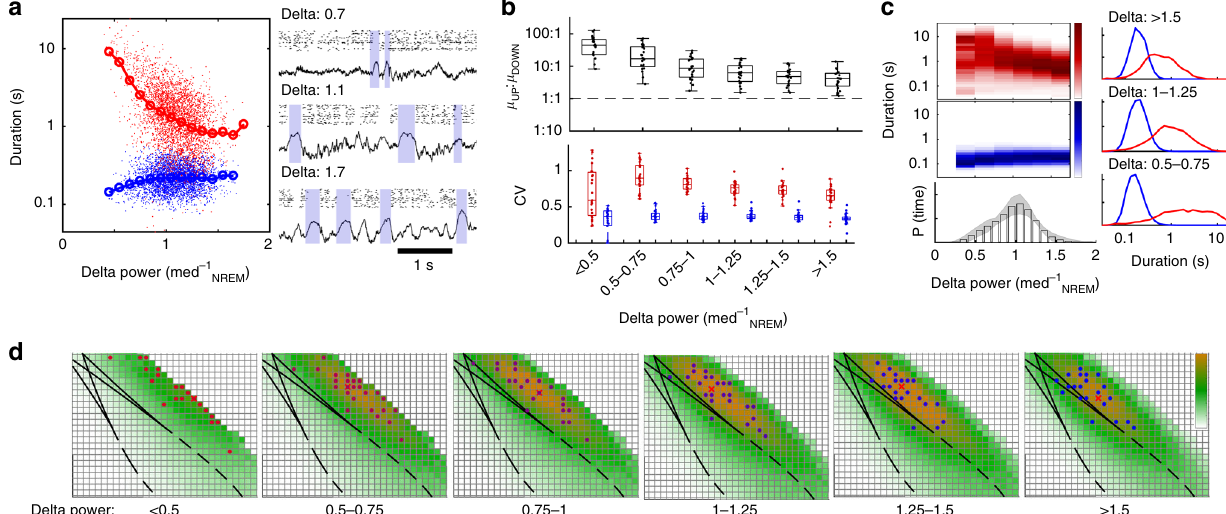
Fig. 5 State-dependent variation in alternation dynamics during NREM sleep. a UP/DOWN state durations as a function of delta (1 – 4 Hz) power in a representative recording (delta power normalized to median power during NREM sleep). b (Top)Ratio of mean UP/DOWN durations in each neocortical recording as a function of delta power. (Bottom) CV of UP/DOWN durations in each neocortical recording as a function of delta power. Center line: media, box limits: upper/lower quartiles, whiskers: data range (excluding outliers). c (Top) Mean distribution of UP and DOWN state durations as a function of delta power in the surrounding 8 s window. Color indicates the observed proportion of UP/DOWN states with a given duration. (Bottom) Mean delta power distribution over all recordings, (error shade: standard deviation). (Right) Mean UP/DOWN state duration distributions for high, medium, and low delta power. d Map of in vivo-model similarity (as in Fig. 4b, with τ r fi xed at τ r = 5 ms), for the delta-power groups as in